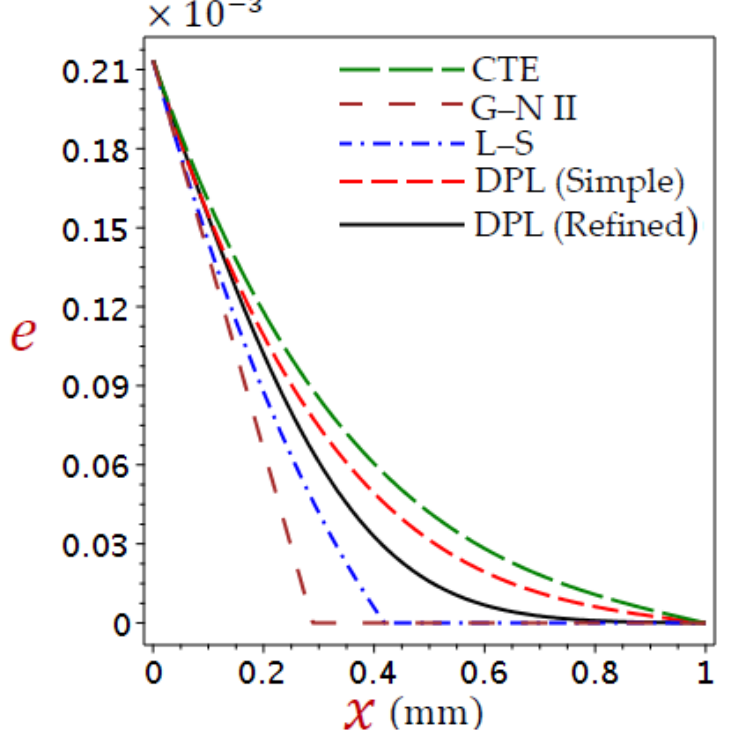
Figure 4. Comparison of variation of dilatation ( e ) across the skin tissue utilizing numerous theo- ries.